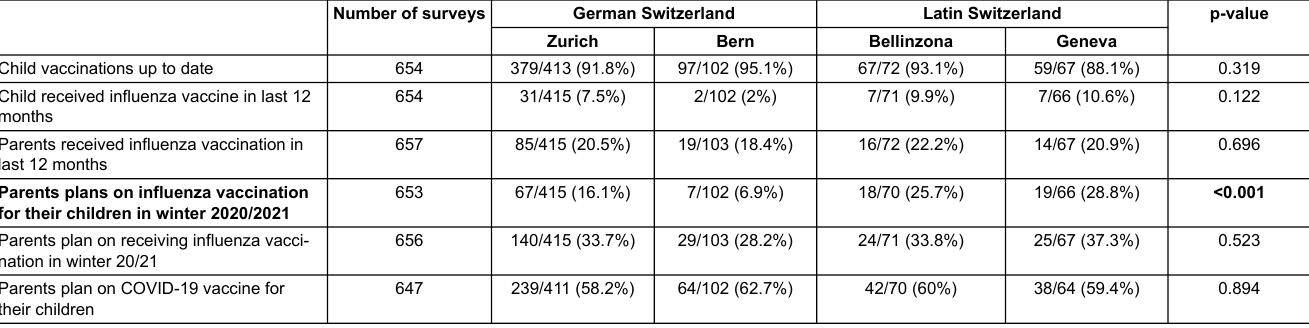
Table 2: Reported vaccination status including influenza vaccination in the previous year and plans for influenza vaccination in the coming season, as well as COVID-19 vaccine and number of surveys in German Switzerland (Zurich, Bern) and Latin Switzerland (Bellinzona, Geneva). Number of surveys